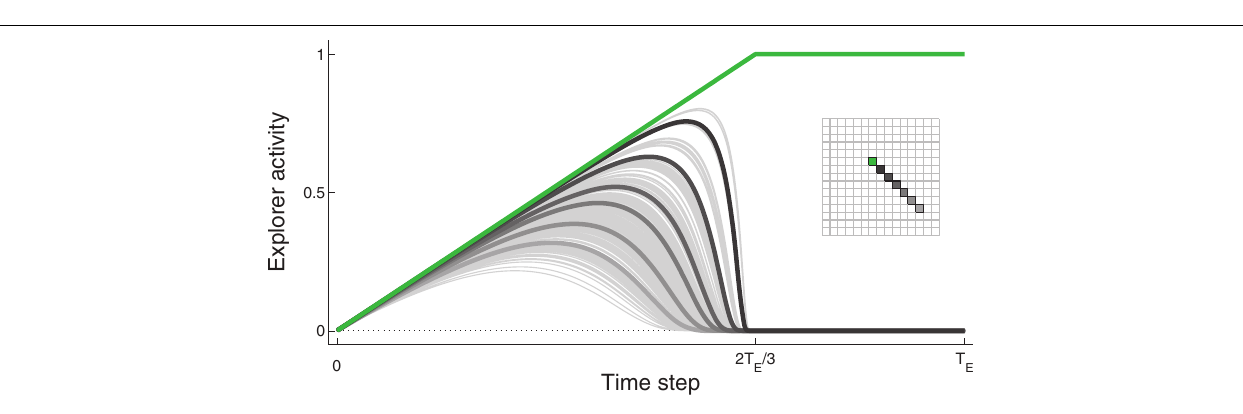
FIGURE 2 | Example of activity of Explorer neurons during a typical movement. The activity of the neuron corresponding to the focus of excitation, G exp , is drawn in green. Selected neurons, colored in the inset, are